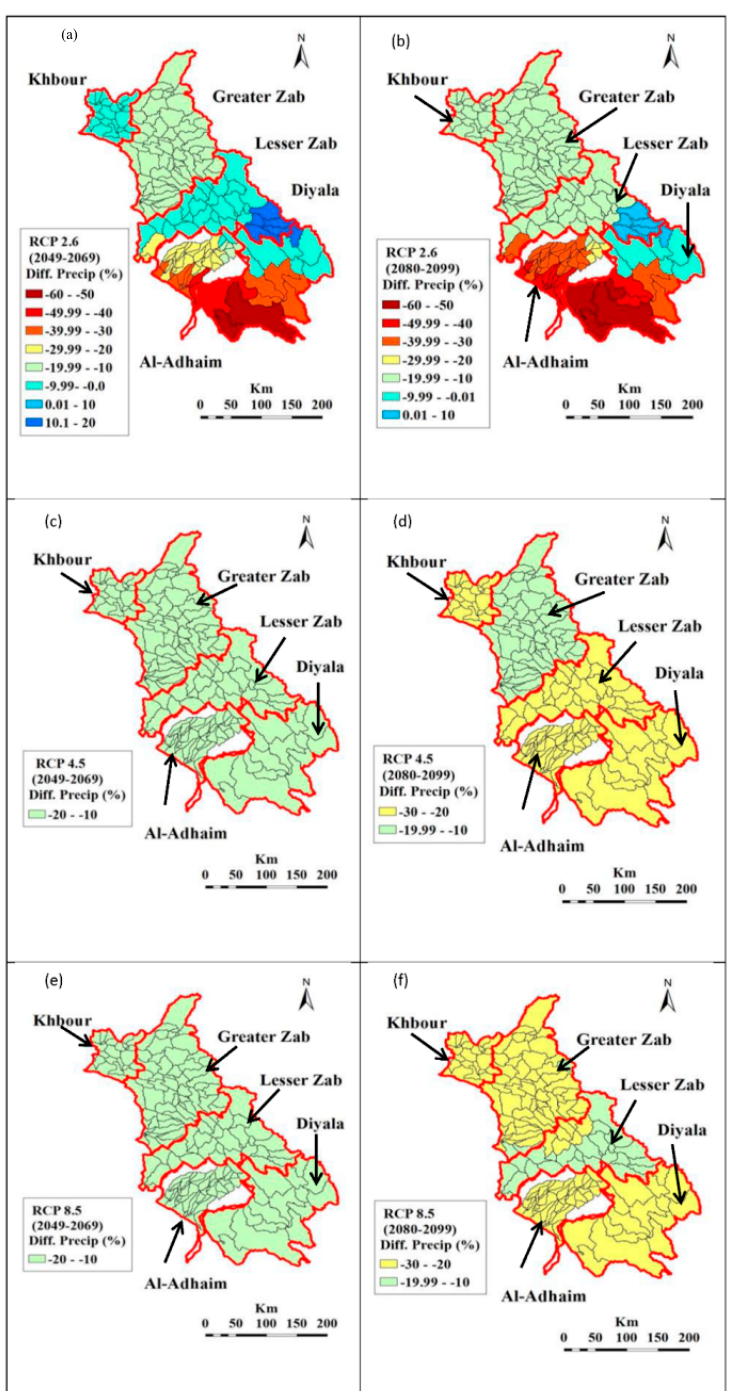
Figure 8. The impacts of climate change on the blue water of the five basins ( a ) Anomaly based on scenario RCP2.6 for the period 2049–2069, ( b ) Anomaly based on RCP2.6 for 2080–2099, ( c ) Anomaly based on RCP4.5 for 2049–2069, ( d ) Anomaly based on RCP4.5 for 2080–2099, ( e ) Anomaly based on RCP8.5 for 2049–2069, and ( f ) Anomaly based on RCP8.5 for 2080–2099.